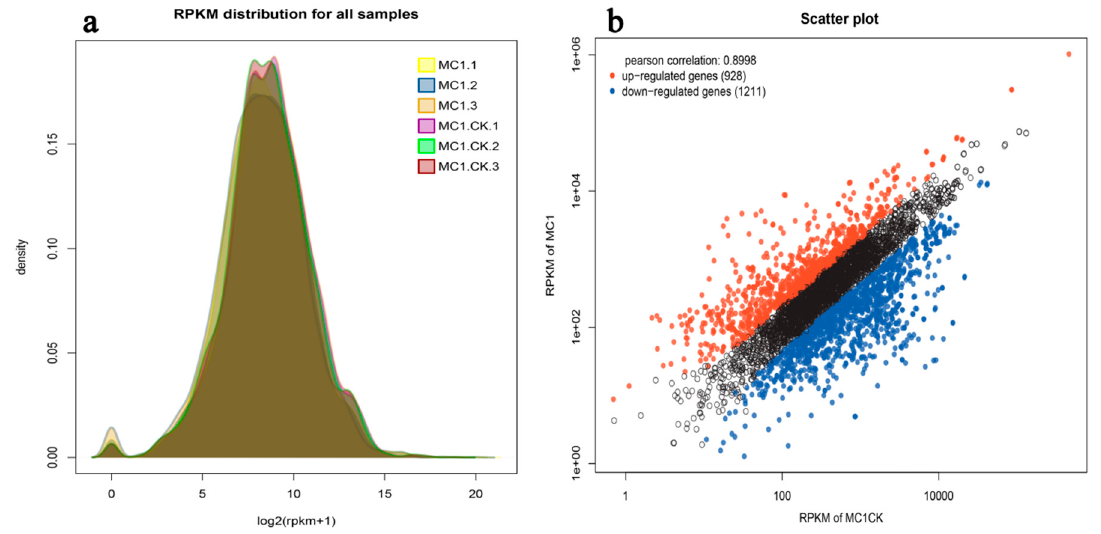
Figure 2. Expression level (reads per kilobase of transcript per million reads mappedscores) distribution map ( a ) and visualized scatter plot of differentially expressed genes ( b ). Black scatters represent undifferentially expressed genes.